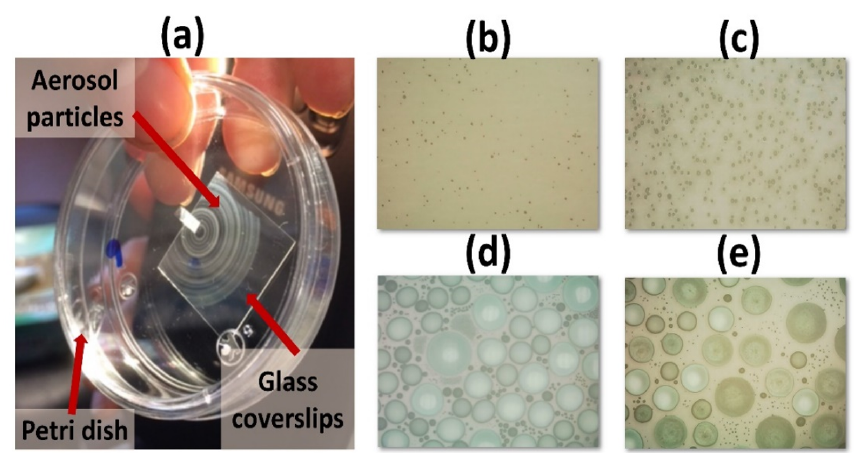
Figure 2. (a) Aerosol particles collected on a hydrophobic glass coverslip, (b) aerosol particles seen from the microscope ( d = 5 . 6–10µm), (c) water vapor condensation on the aerosol particles, (d) liquid droplets, and (e) frozen (opaque colors) and unfrozen droplets as seen by the optical microscope.